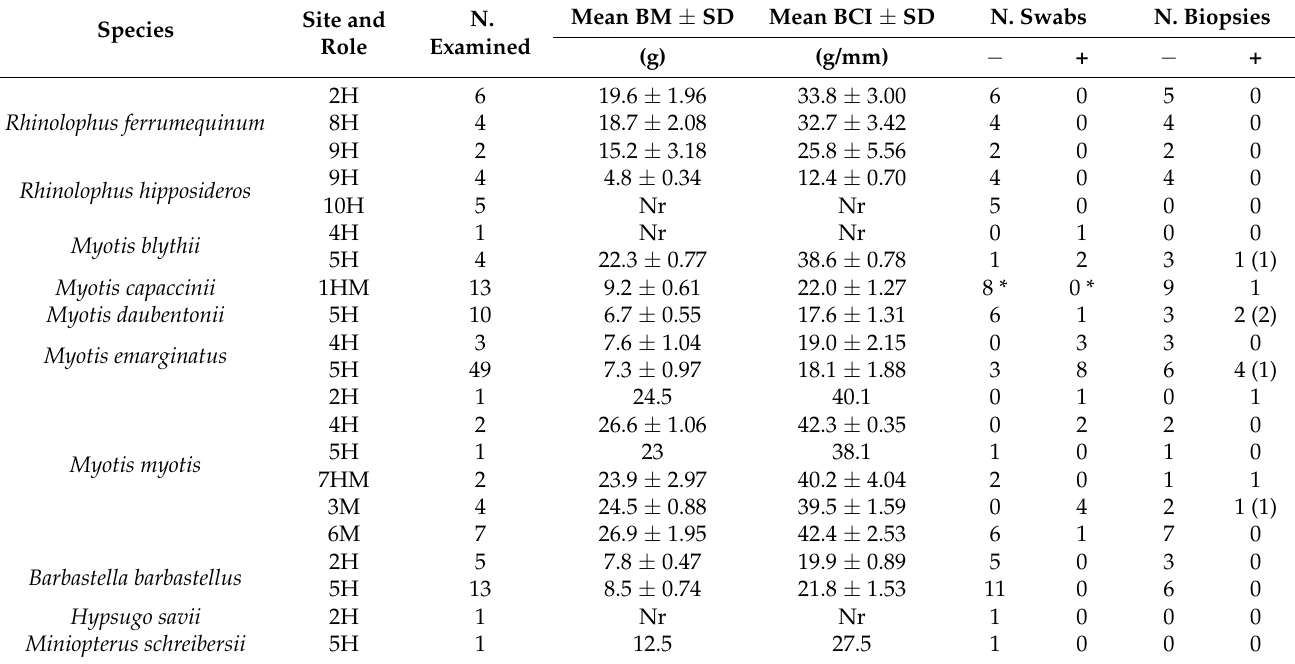
Table 1. Bats examined and individuals investigated through culture (positive/negative for P. destructans ) and histological (positive/negative for fungal presence) analyses. In brackets, the number of individuals for which a dermal infiltration by hyphae was observed.